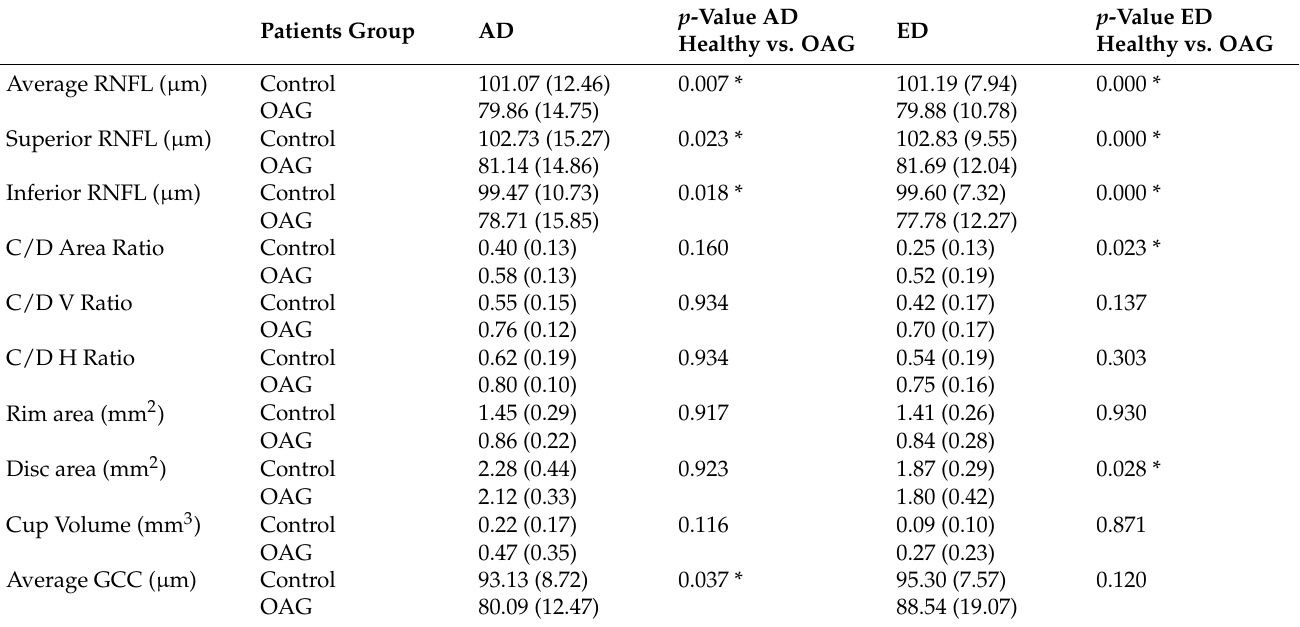
Table 2. Mean and standard deviation of the optical coherence tomography parameters and com- parisons ( p -values) in control and open-angle glaucoma (OAG) patients of African descent (AD) and European descent (ED). C/D: cup-to-disc; GCC: ganglion cell complex thickness; H: horizontal; RNFL: Retinal Nerve Fiber Layer thickness; V: vertical. * p < 0.005. Patients Group